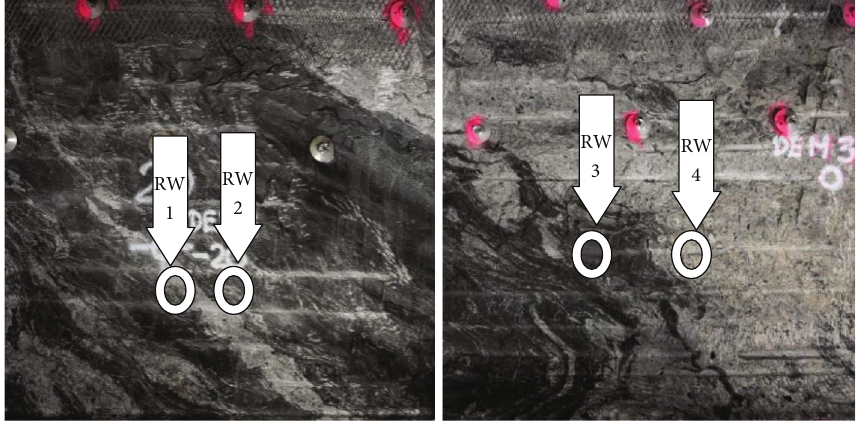
Figure 8: Demo 3 right